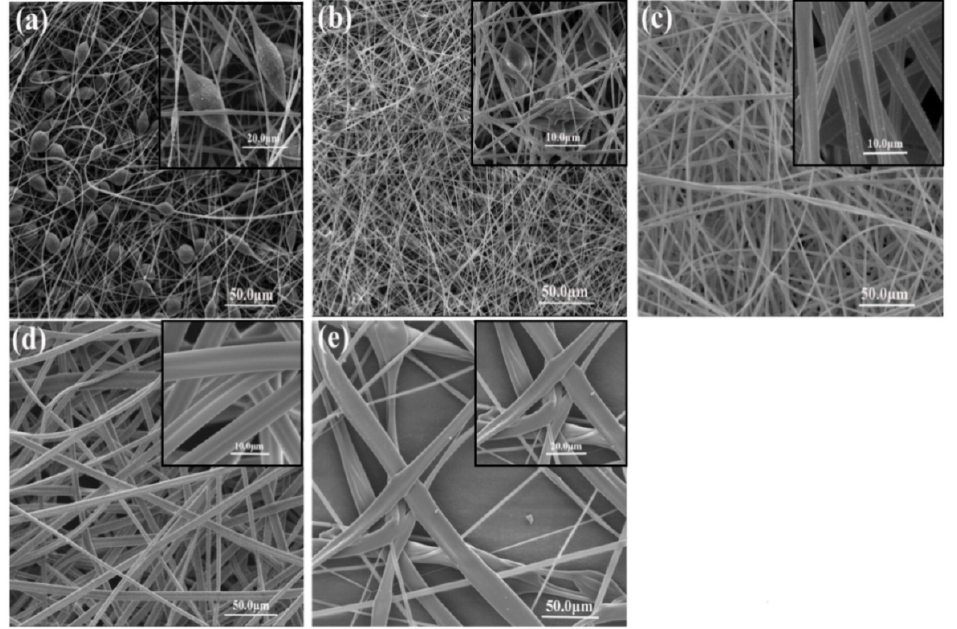
Figure 2. Scanning electron micrographs of electrospun PS fibers on stationary Al foil of 80 rpm, 23 (w/v)% solution concentration and applied voltage of 15 kV with different solvent combinations ( a ) DMF/THF = 100/0; ( b ) DMF/THF = 75/25; ( c ) DMF/THF = 50/50; ( d ) DMF/THF = 25/75; ( e ) DMF/THF =